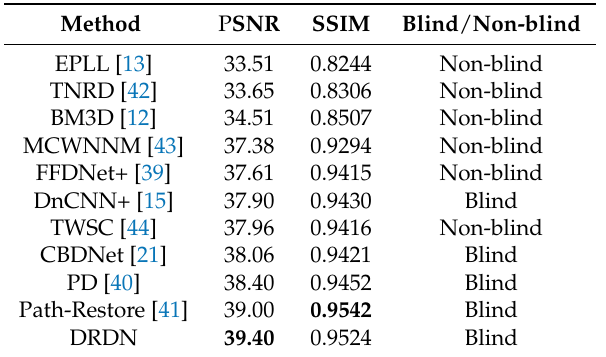
Table 2. Results of real-world denoising on the Darmstadt Noise Dataset [38]. Best performance is in